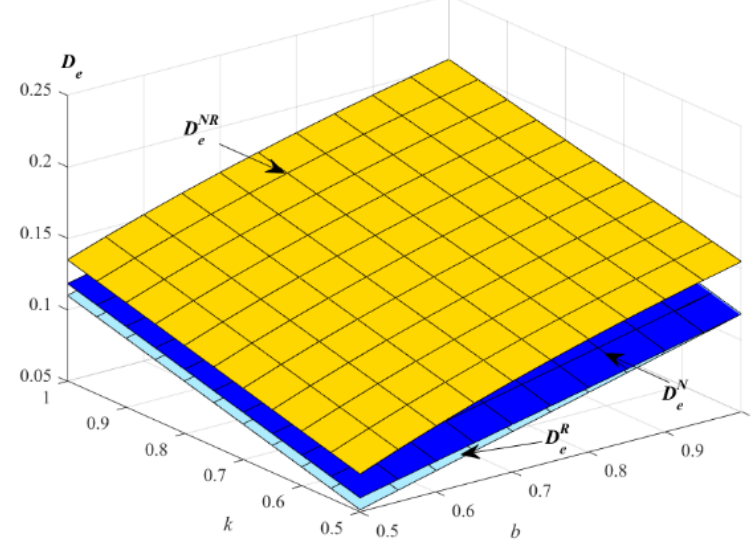
Figure 5. Impact of k and b on the optimal demand of EWS.